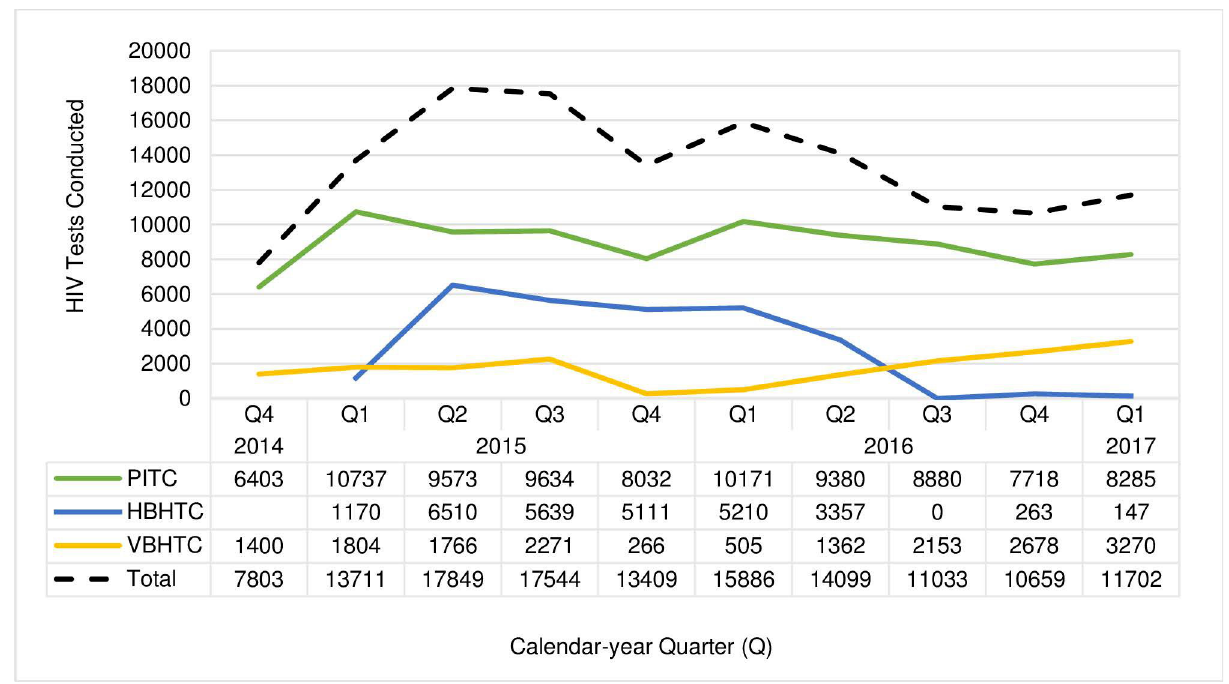
Fig 2. HIV tests conducted by calendar-year quarter and HIV testing strategy, Bukoba Combination Prevention Evaluation, Bukoba Municipal Council, Tanzania, 2014-2017. a PITC, provider initiated testing and counseling; HBHTC, home-based HIV testing and counseling; VBHTC, venue- based HIV testing and counseling. a PITC began in Q4 2014 in seven of 11 health facilities and was implemented in all 11 facilities during Q1 2015 –Q1 2017. HBHTC teams visited all Bukoba Municipal Council (BMC) households on the mainland and offered HIV testing to encountered persons